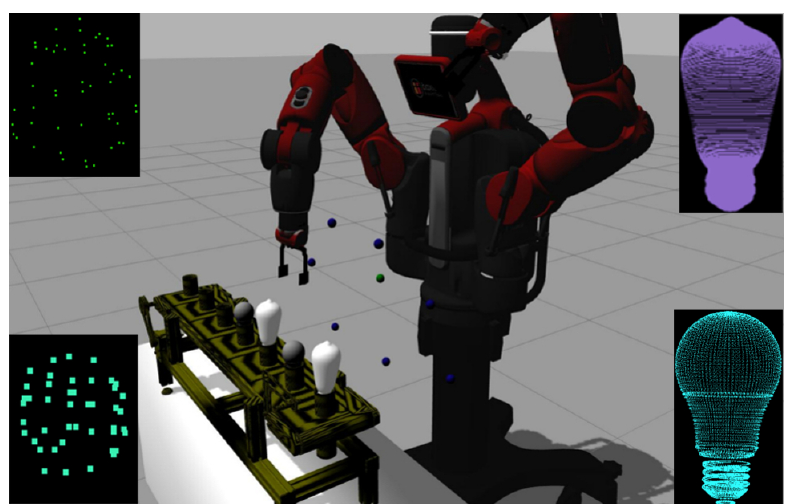
Figure 6. The robot sampling a set of points and testing their rechability in a simulated environment. The models for livarno and elongated light bulbs ( right side ) and the corresponding sampled point clouds used for classification of the light bulbs ( left side ).